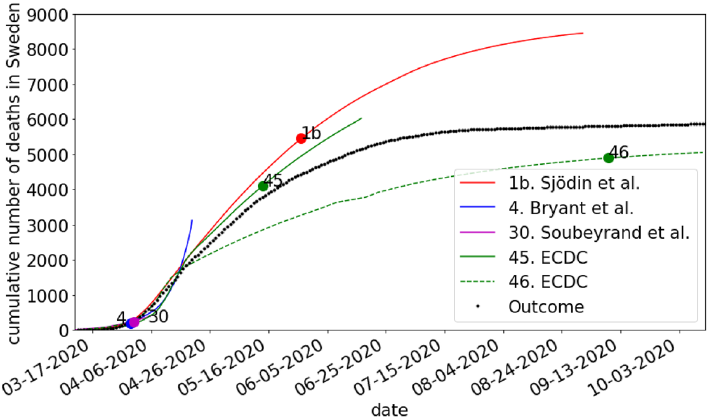
Figure 4. Comparison of modelled and actual number of deaths in Sweden during 2020. The circles on the curves show the date up until which data was used for calibrating the model.